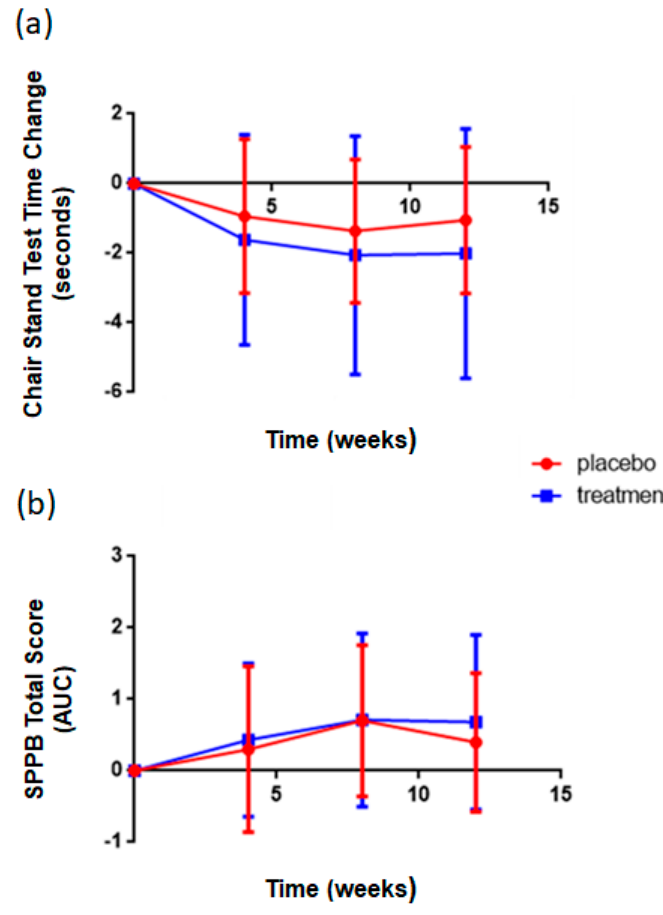
Figure 4. E ff ect of rice NPN supplementation on lower body strength and overall performance in short physical battery compared to placebo treated controls. ( a ) Changes in repeated chair stand test time at various intervals after the start of consumption of either placebo or rice NPN (treatment) are expressed. Each symbol represents the mean + 1 x +/ − s.d. of 10 persons in placebo and at least 27 in rice NPN group. ( b ) Changes in SPPB total score at various intervals after the start of consumption of either placebo or rice NPN are expressed as area under the curve (AUC). Each symbol represents the mean + 1 x +/ − s.d. of 10 persons in placebo and at least 28 in rice NPN group. Values are mean ± SEM.